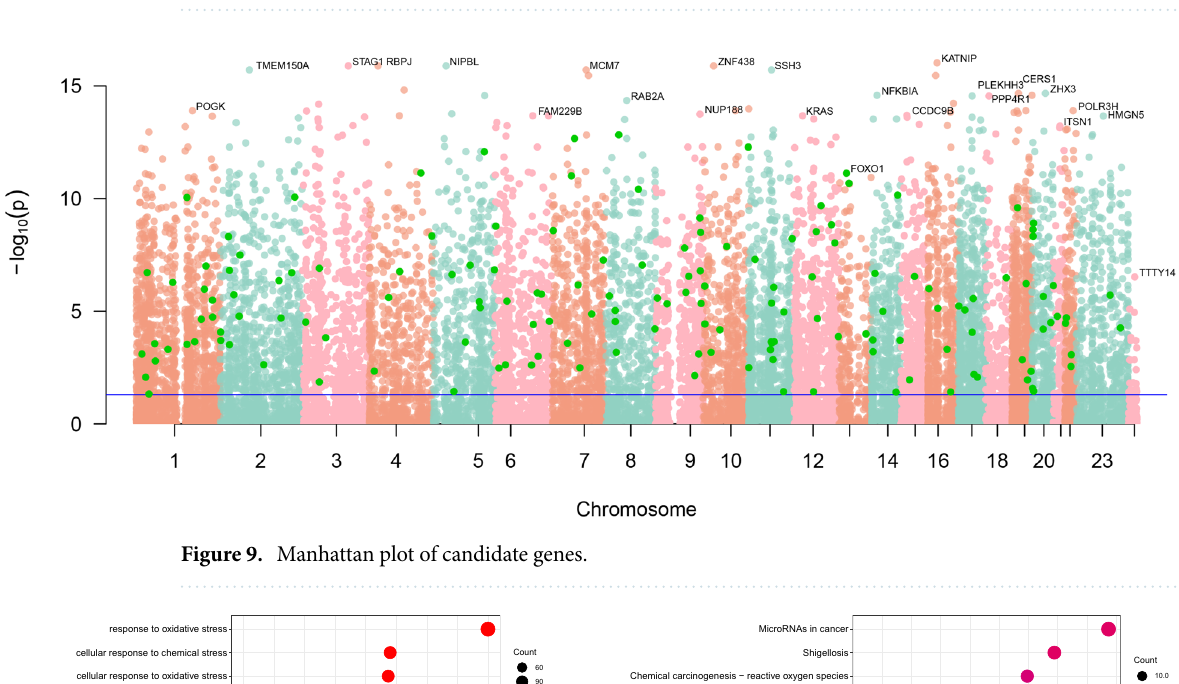
Figure 8. ( a ) Wayne diagram of candidate hub gene screening. ( b ) Chromosomal locations of candidate hub genes. The gene expression petterns of these genes in the GSE132903 datasets are represented in the inner circular heatmaps. Red indicates gene up-regulation, blue represents downregulation, and the outer circle of heatmap represents the control group, the inner circle of heatmap represents the disease group. The outer circle represents chromosomes; lines coming from each gene point to their specific chromosomal locations.